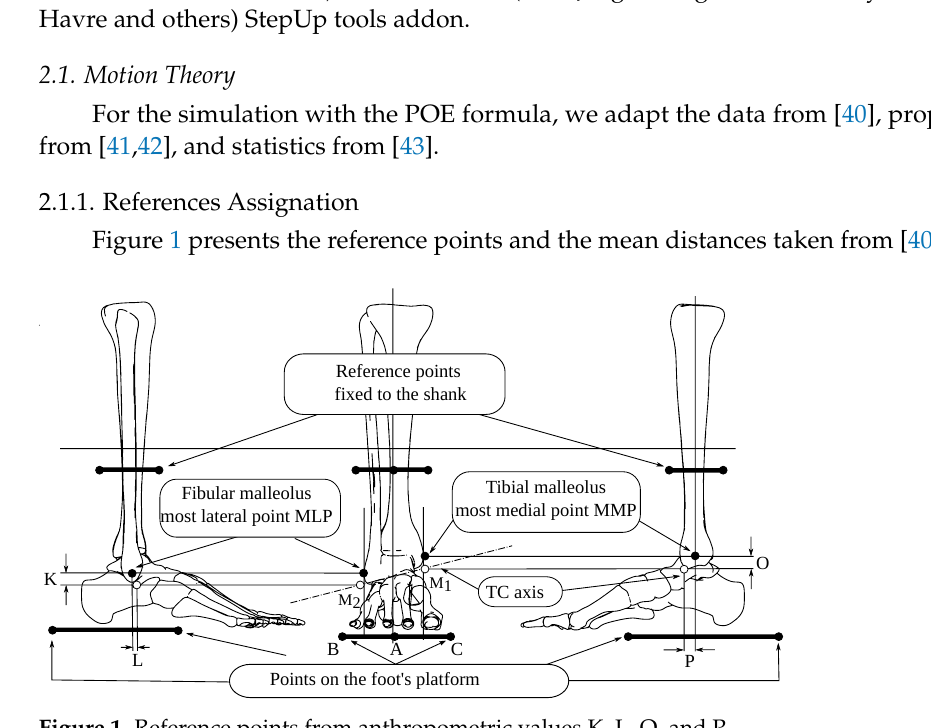
Figure 1. Reference points from anthropometric values K, L, O, and P. A, B, and C are the triangle’s vertices in a platform fixed to the foot, the K, L, and O distances from the most medial and lateral points from the black-filled to the white-filled marker. M 1 and M 2 define the talocrural (TC) axis. We show top-transverse and right- lateral views in Figure 2 with distances Q, W, and w. N 1 and N 2 determine the subtalar (ST)